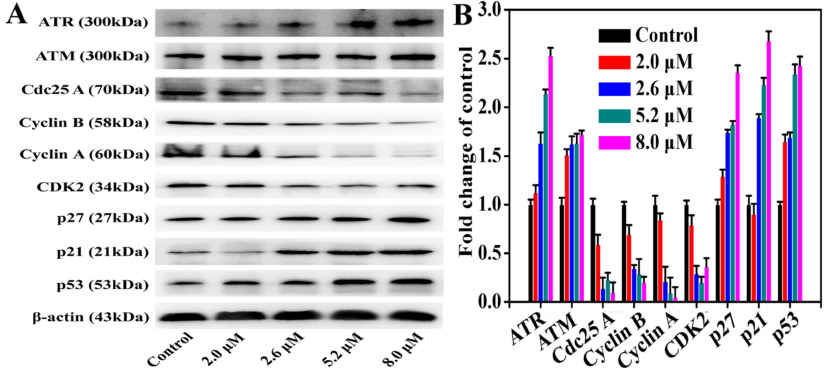
Figure 4. The expressions of ATR, ATM, Cdc25 A, Cyclin B, Cyclin A, CDK2, p27, p21, and p53 protein in MGC80-3 cells after treated with complex 1 (2.0, 2.6, 5.2, and 8.0 µ M) for 24 h were analyzed by Western blot. ( A ) The same blots were stripped and re-probed with a β -actin antibody to show equal protein loading; ( B ) The whole-cell extracts were prepared and analyzed by Western blot analysis using antibodies against cell cycle protein regulator proteins. The same blots were stripped and re-probed with the β -actin antibody to show equal protein loading. Western blotting bands from three independent measurements were quantified with Image J in ( A